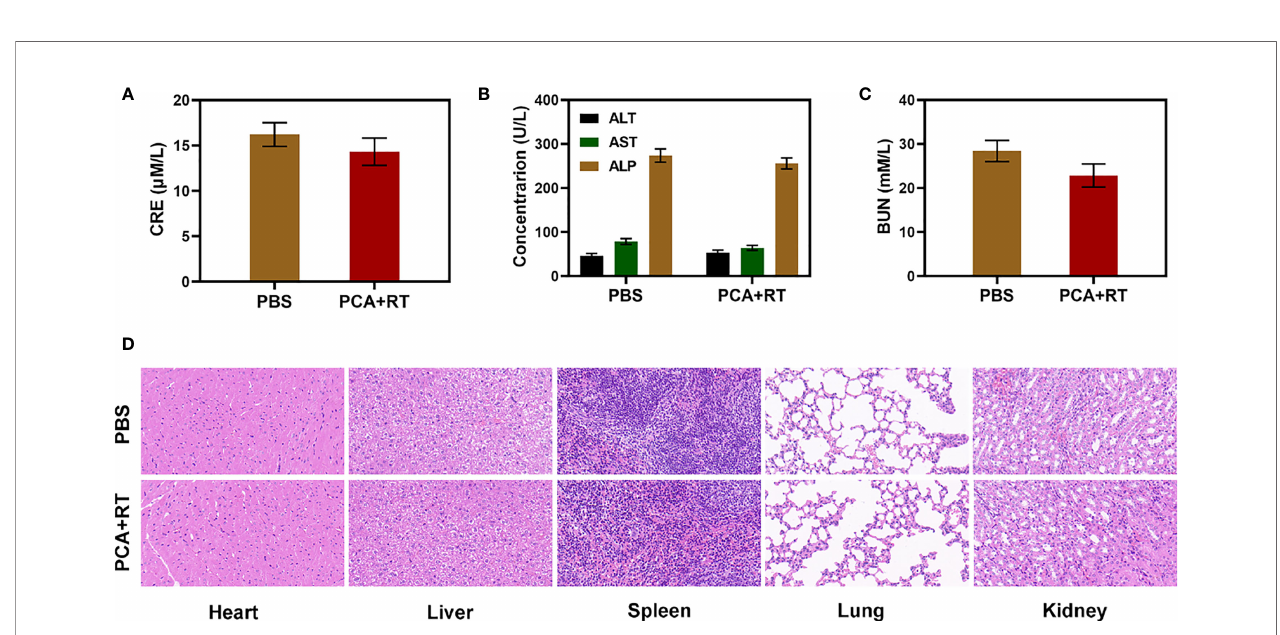
FIGURE 4 | Result of in vivo safety experiments. Blood biochemistry data including kidney/liver function markers: (A) CRE, (B) ALT, ALP, and AST, and (C) BUN after various treatments. (D) Histopathological analysis results (H&E) stained images of the major organs, heart, lung, liver, kidneys, and spleen, of mice that were exposed to different treatments 16 days ’ post-injection under laser irradiation.